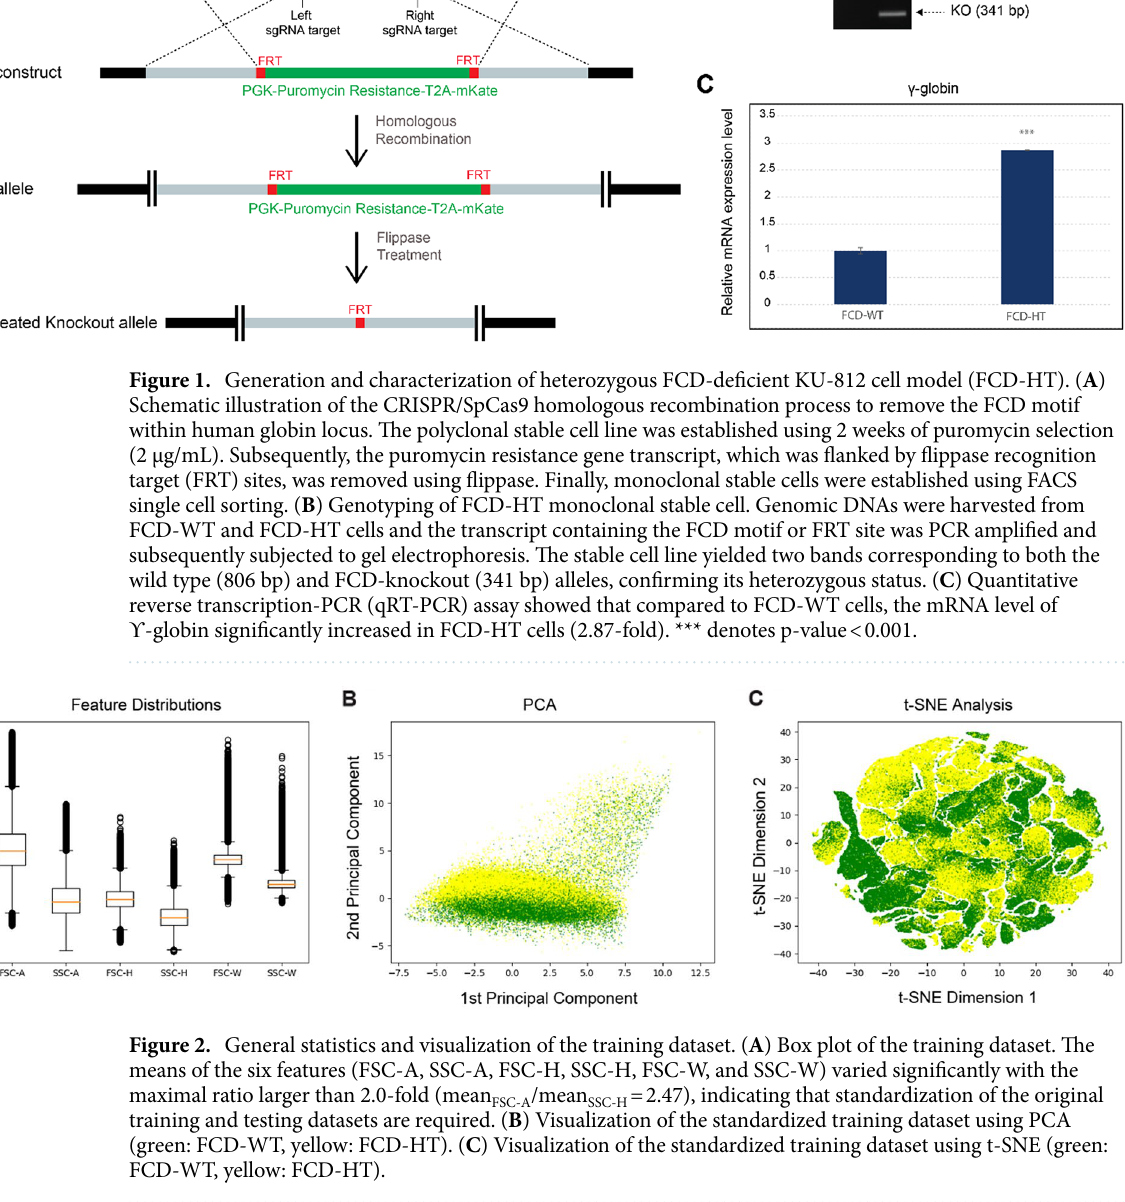
Fig. 2C (t-SNE), the two cell subpopulations (FCD-WT: green, FCD-HT: yellow) overlapped significantly and were not linearly separable, which implies that non-linear modeling approaches such as multilayer perceptron may be required for classification purposes.